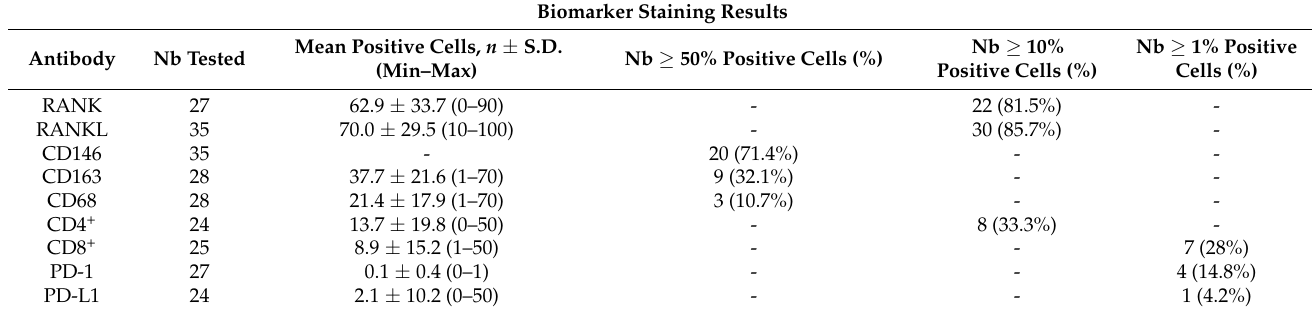
Table 2. Biomarker staining results and correlations. n, number of patients; S.D., standard